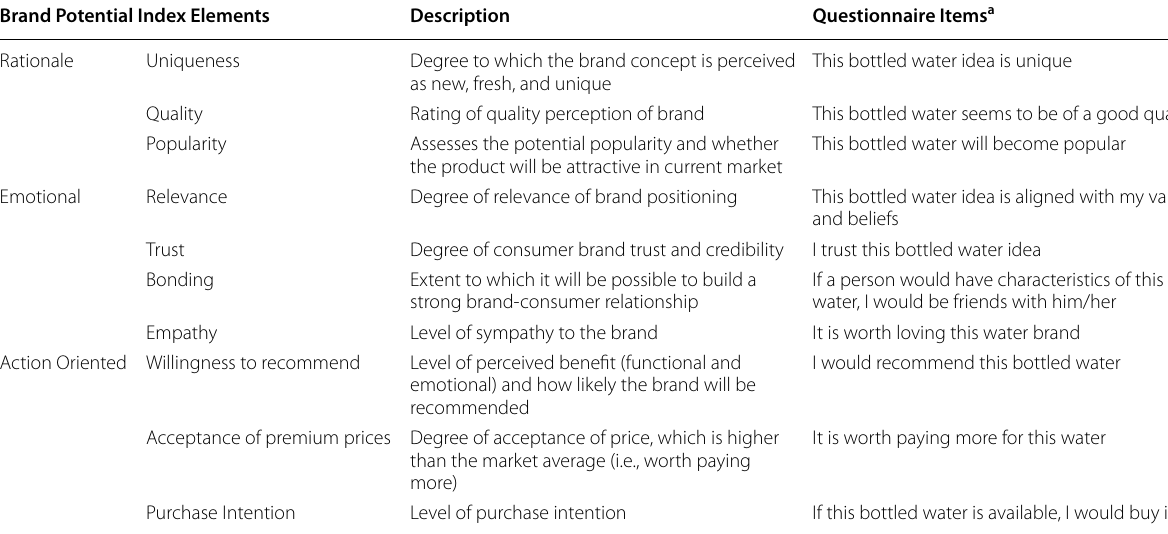
Table 3 Brand Potential Index (BPI) Elements and Questionnaire